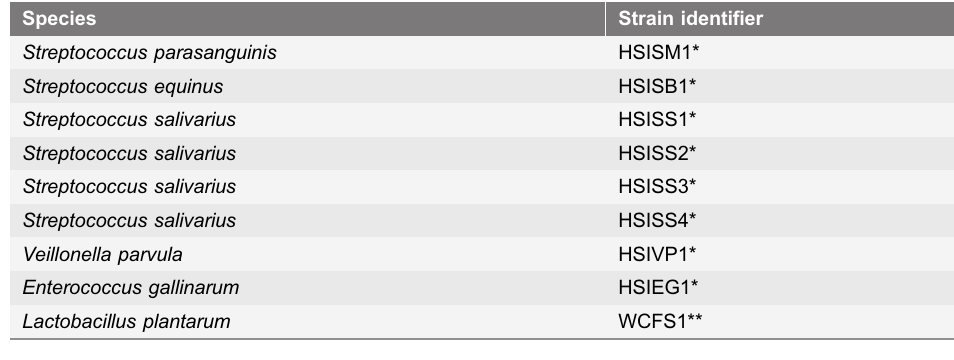
Table 1. Strains used in this